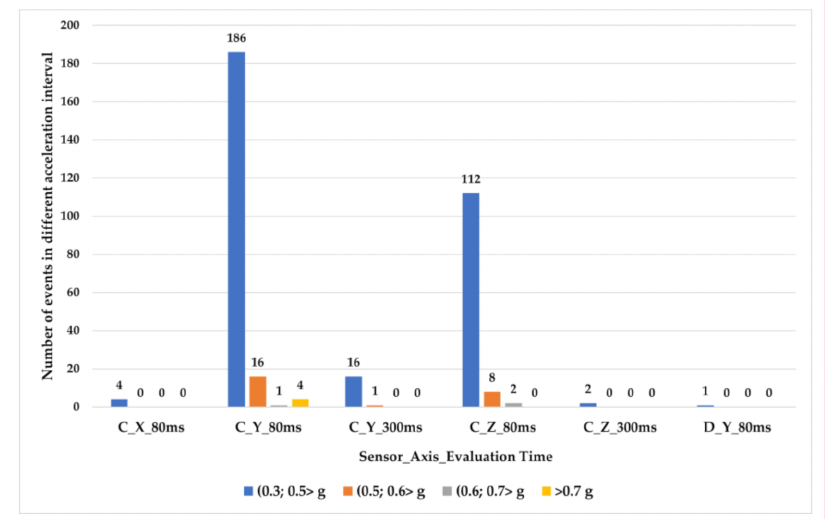
Figure 17. Numbers of events per particular acceleration